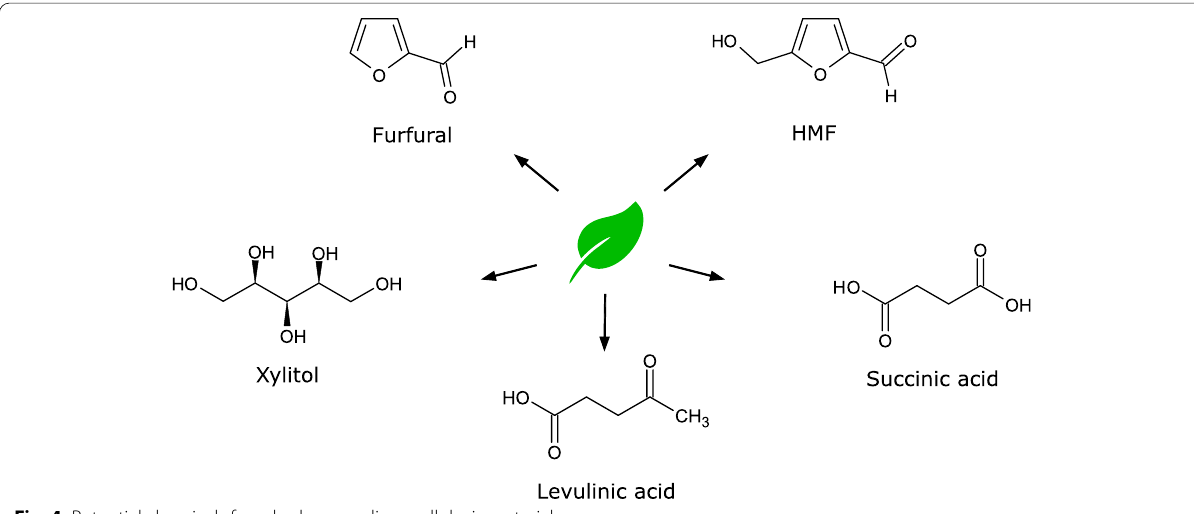
Fig. 4 Potential chemicals from herbaceous lignocellulosic